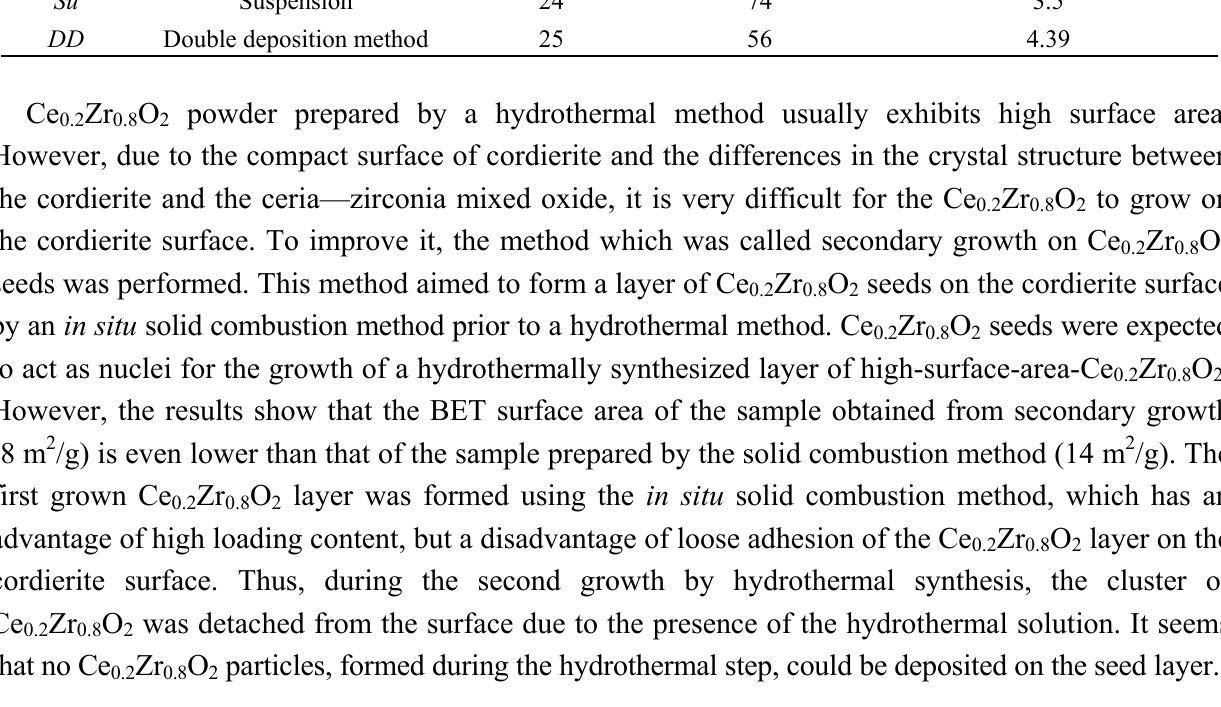
/cordierite samples prepared by different deposition method. 2